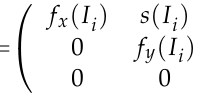
, B c , B r in the left ERP image; ( b ) B l L L L